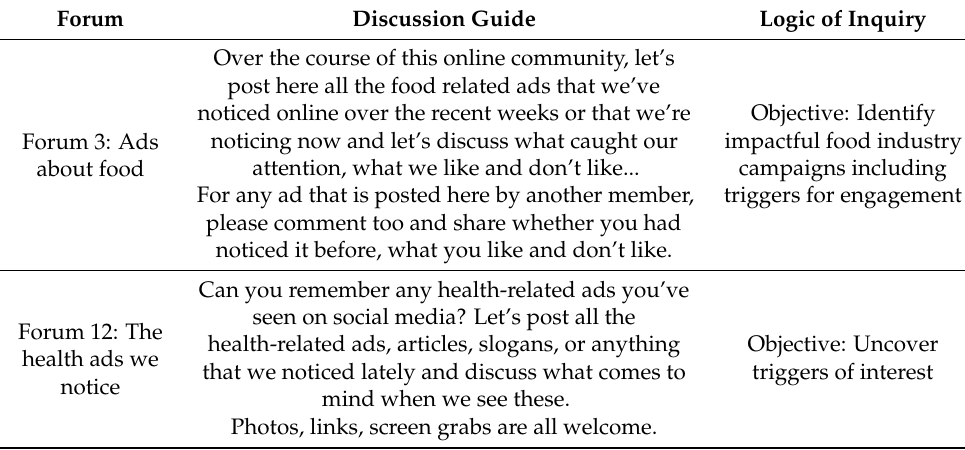
Table 1. Discussion guide and logic of